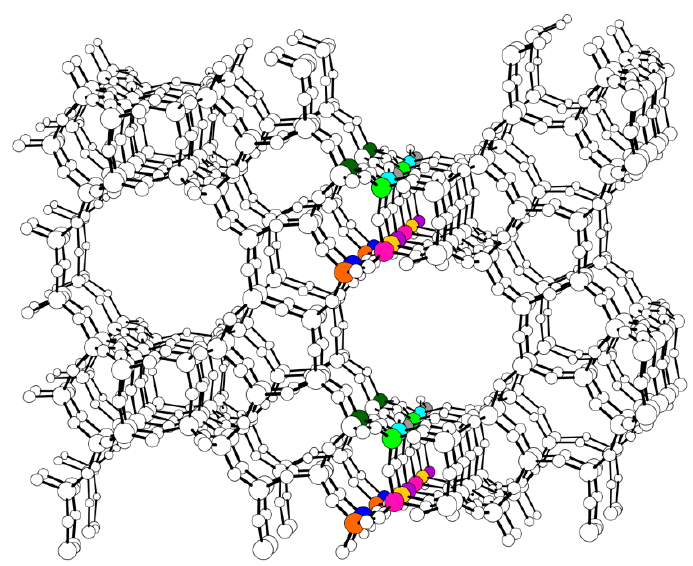
Figure 1. Crystal structure of BEA zeolite. Nine non-equivalent T sites are highlighted (T1—magenta, T2—bright green, T3—yellow, T4—cyan, T5—violet, T6—grey, T7—blue, T8—dark green, T9— orange).